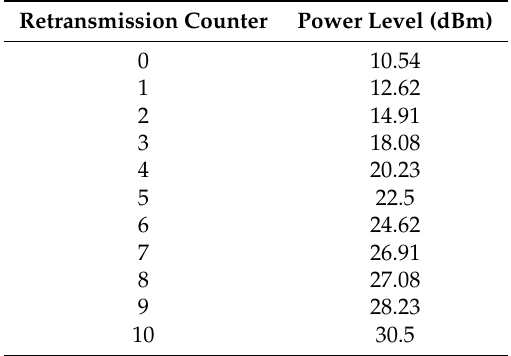
Table 3. Transmission power levels for adaptive transmission power